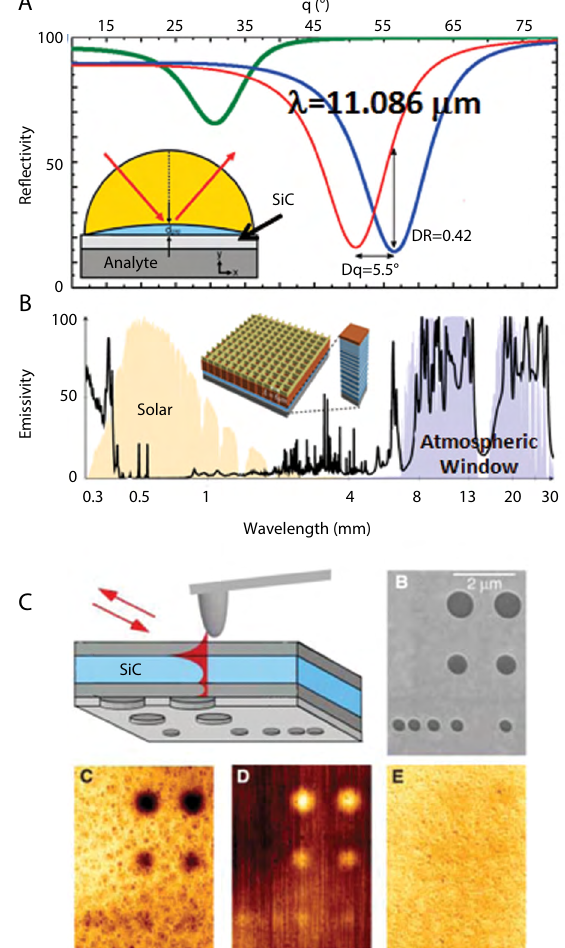
Figure 12 (A) Demonstration of infrared index-based biosensing using SPhP modes in SIC. (B) Schematic of the optimized daytime radiative cooler design based on SPhP materials SiC and SiO with MgF /TiO /Ag reflectors and the calculated emissivity of the 2 2 structure at normal incidence (black curve). The AM1.5 solar spec- trum and atmospheric transmittance window are also provided as the yellow and blue regions, respectively. (C) Schematic of SNOM- based detection scheme used to collect the superlens images of the sub-diffraction particles. Reproduced with permission from